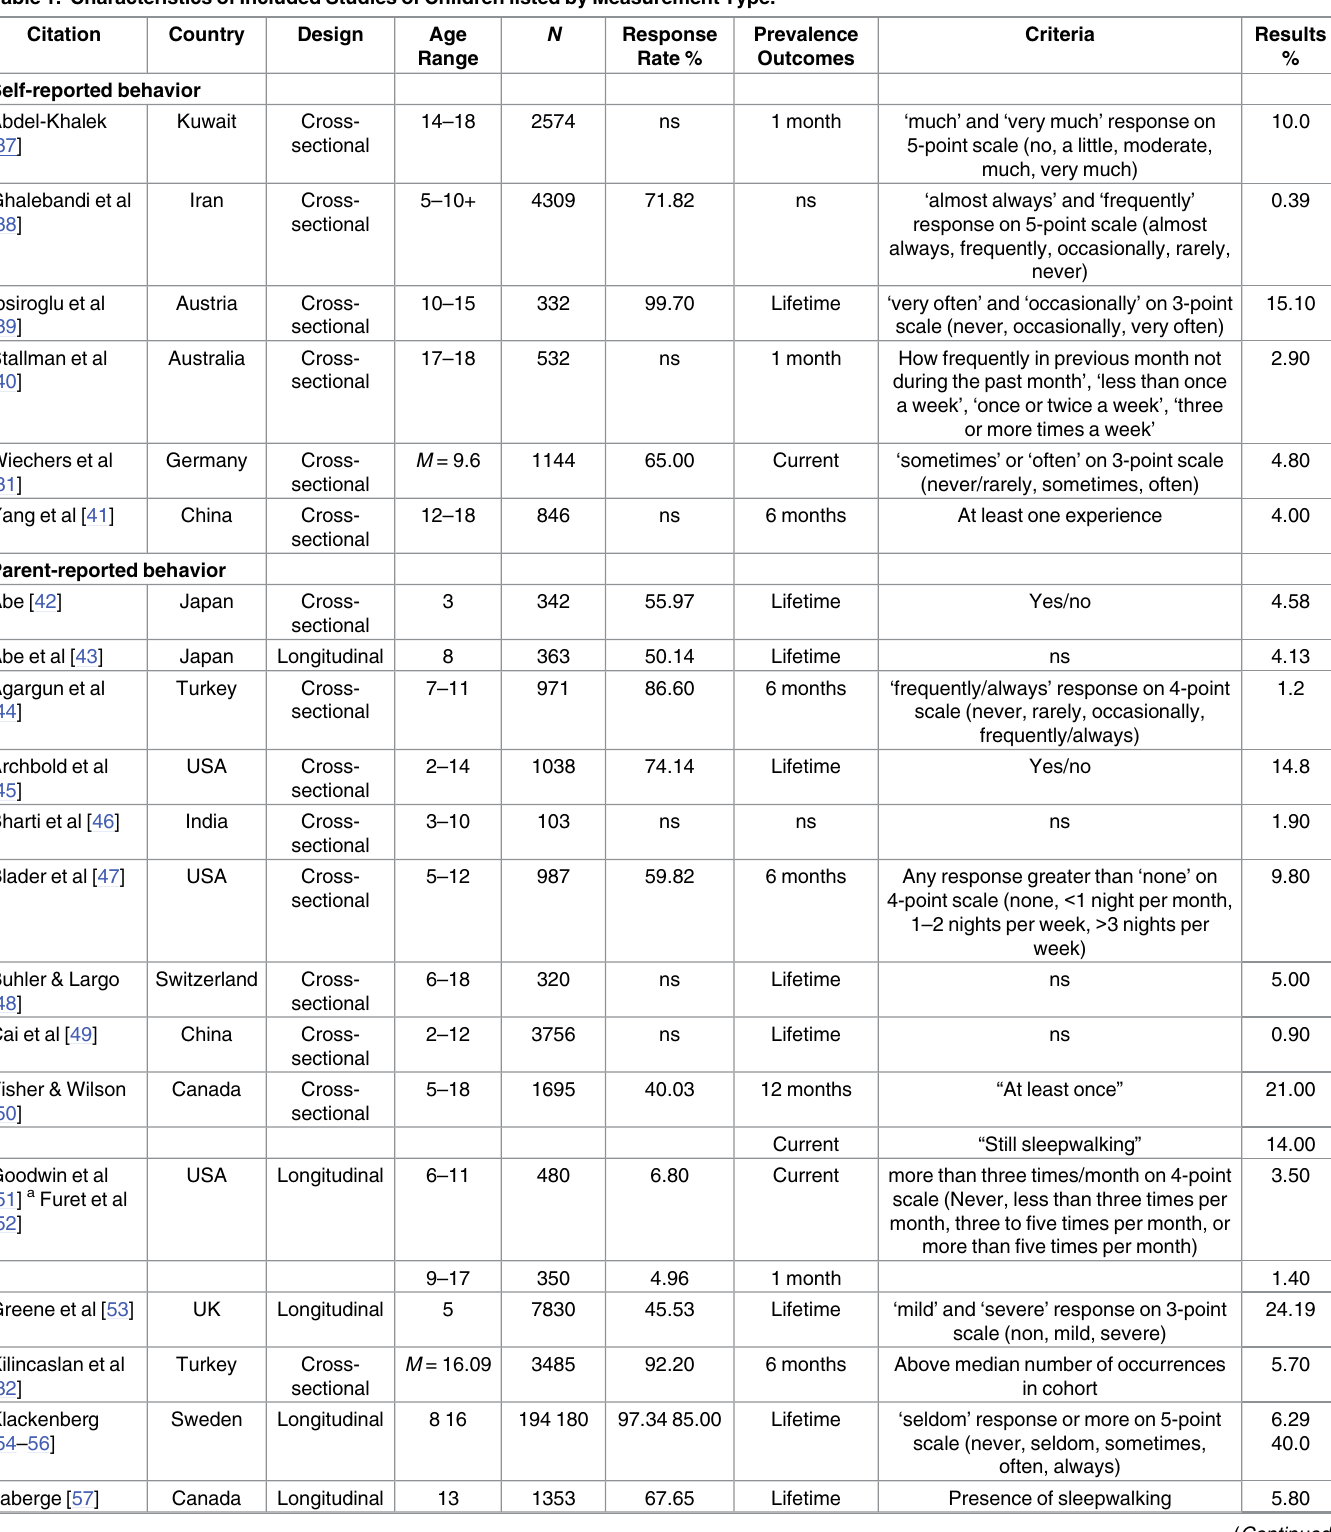
Table 1. Characteristics of Included Studies of Children listed by